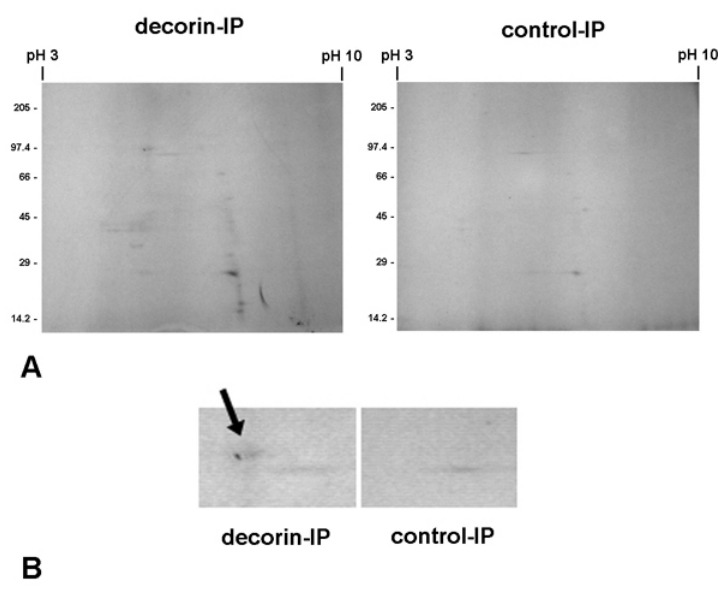
FIGURE 7. Separation of cross-linked decorin-receptor complexes by 2D electrophoresis. Cross-linking of intracellular decorin-receptor complexes and immunoprecipitation were performed as described in the legend of Fig. 6. Proteins precipitated with preimmune serum (control) or with decorin antiserum (decorin), respectively, were separated in the first dimension by denaturing IEF in a continuous pH gradient ranging from pH 3–10. Separation in the second dimension was achieved by SDS-PAGE on a 12.5% gel. Proteins were visualized by autoradiography of the dried gels (A). (B) Magnified region from (A): an additional protein band of a molecular mass of about 107 kDa with an isoelectic point of about 5.5 can be detected on the autoradiogram of proteins immunoprecipitated with decorin antiserum compared to preimmune